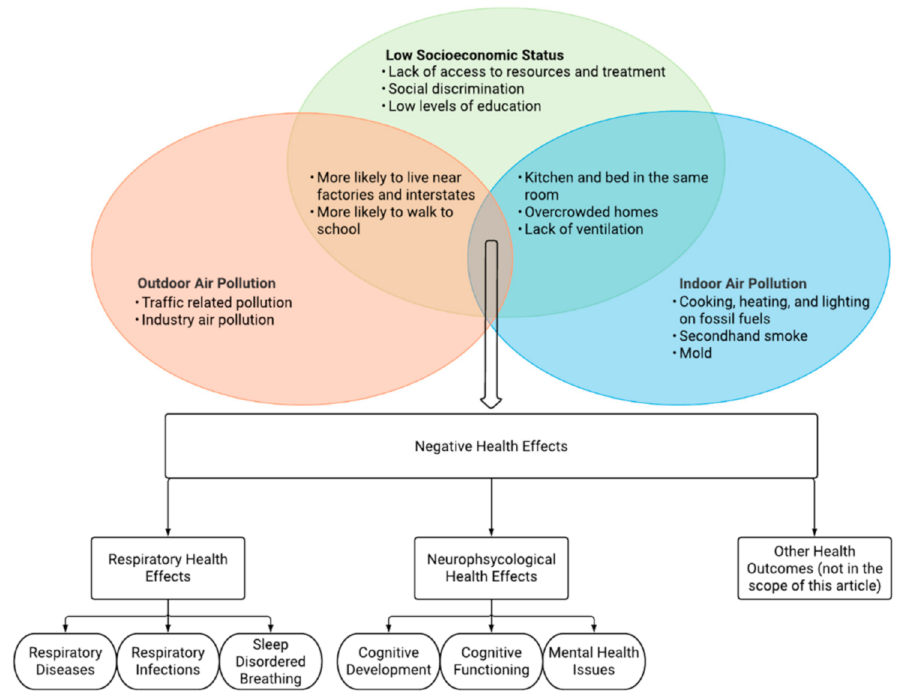
Figure 1. Environmental injustice. The detrimental intersection of outdoor and indoor air pollution with socioeconomic status and its consequences for children’s